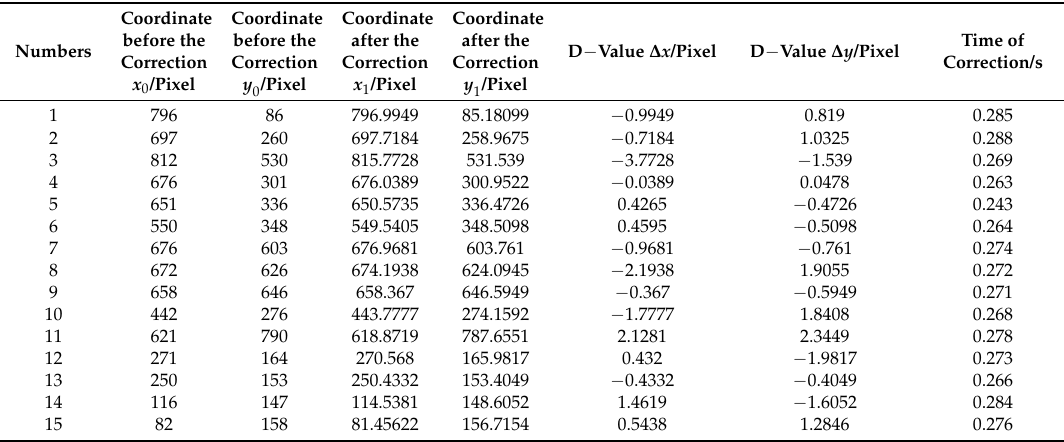
Table 3. The coordinate comparison table before and after the correction of the 0702